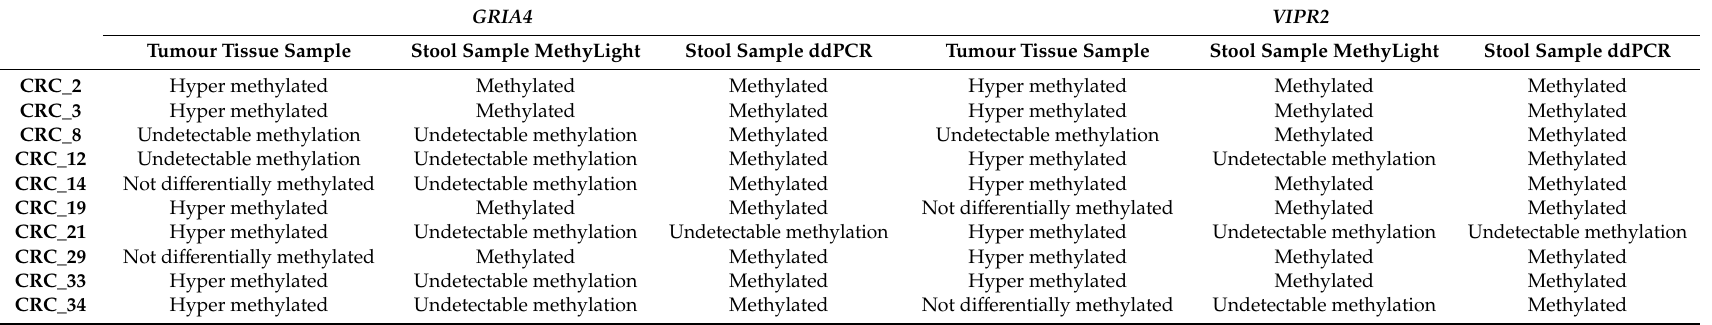
Table 2. GRIA4 and VIPR2 methylation analyses